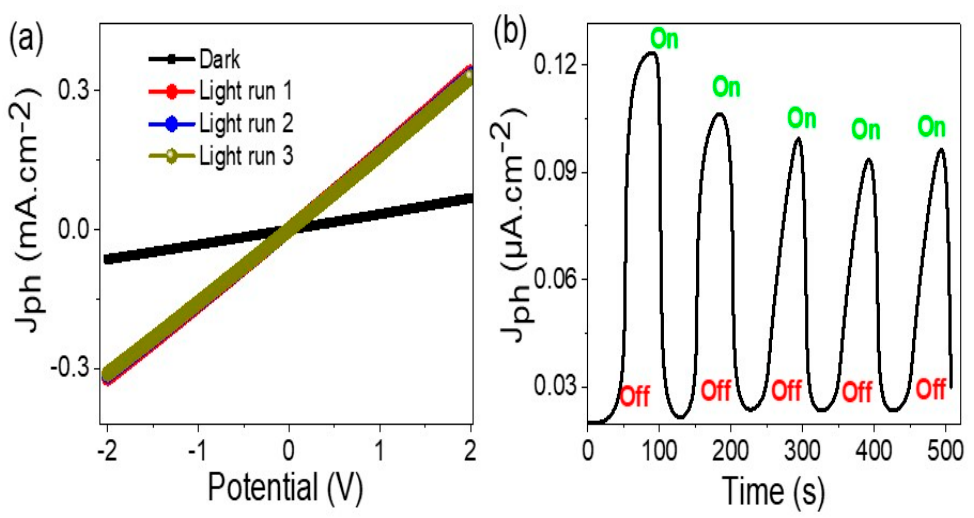
Figure 5. ( a ) The electrical study of the prepared roll-GO/PANI photodetector to the incidence photons in in ( a ) normal and ( b ) chopped off/on light conditions.